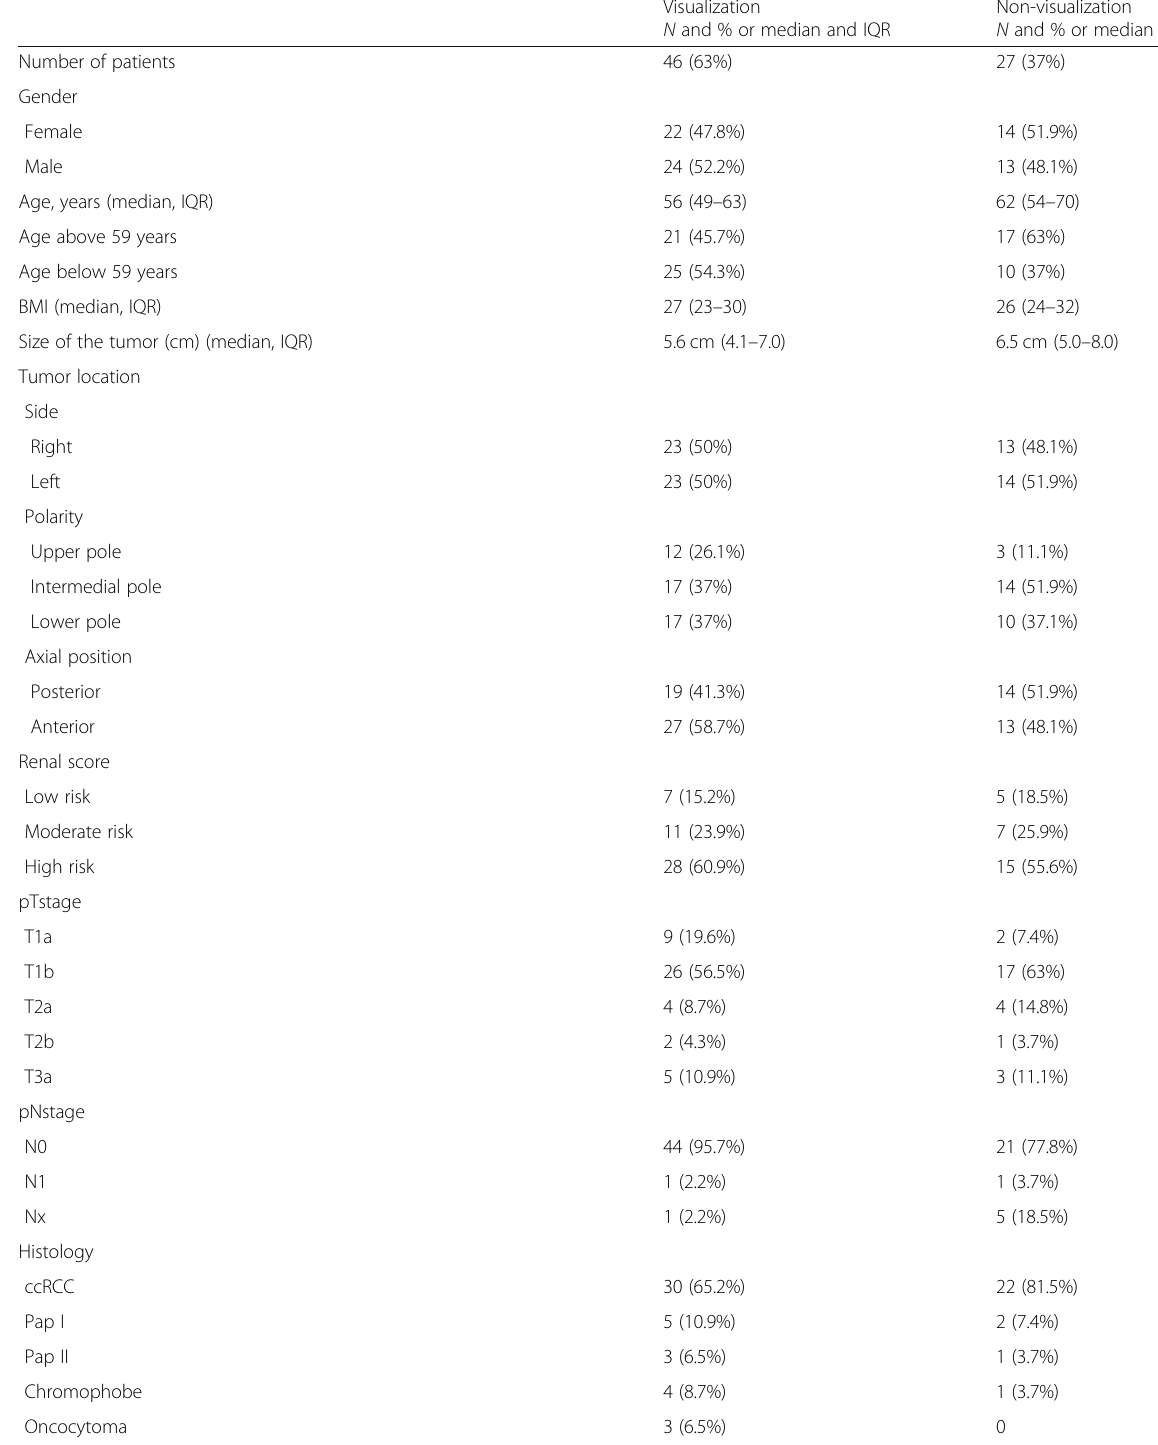
Visualization N and % or median and